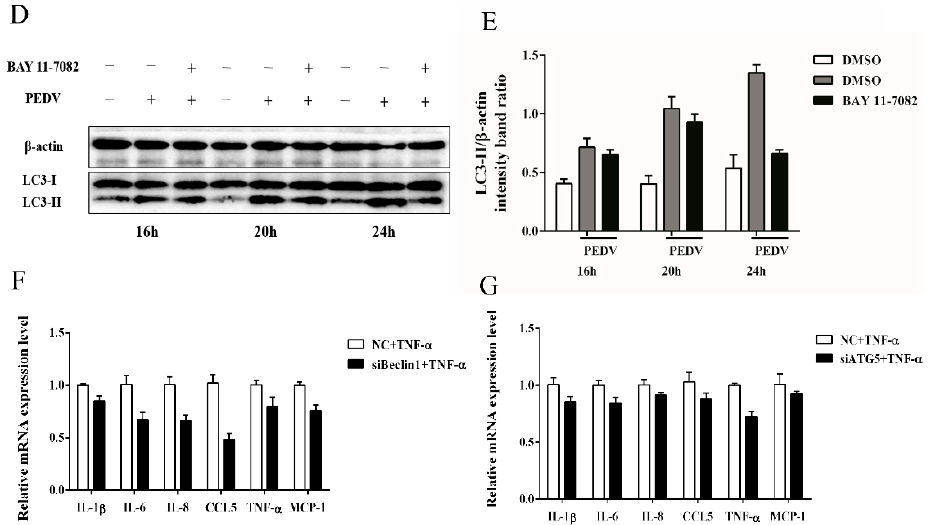
Figure 6. Autophagy mediates the production of inflammatory cytokines and correlates with the NF ‐κ B signaling pathway in PEDV infected Vero cells. ( A , B ) The expression of inflammatory cytokines. Vero cells were transfected with siRNA targeting Beclin1 , ATG5 , or negative control (NC) for 24 h, followed by PEDV infection (0.1 MOI). The mRNA levels of cytokines were determined at 24 hpi by quantitative real ‐ time PCR. ( C ) The level of LC3 ‐ II, p65, or phospho ‐ p65 was also examined separately at 24 hpi with the corresponding antibodies by Western blot. The intensity band ratios of LC3-II to β -actin and p-p65 to p65 were analyzed by using ImageJ software. ( D ) Vero cells were pretreated with 10 µ m BAY11-7082 for 12 h, then followed by PEDV infection for 16, 20, and 24 h, separately. The cell samples were collected for LC3-II detection by Western blot. (E) The intensity band ratio of LC3-II to β -actin was analyzed by using ImageJ software. All data were presented as mean ± SEM of three independent experiments. ( F , G ) Vero cells were transfected with siATG5, siBeclin1, or negative control. Twenty-four hours post-transfection, the cells were treated with TNF- α for 4 h, and then the expression of inflammatory cytokines were determined by qRT-PCR. The data were presented as mean ± SEM of three independent